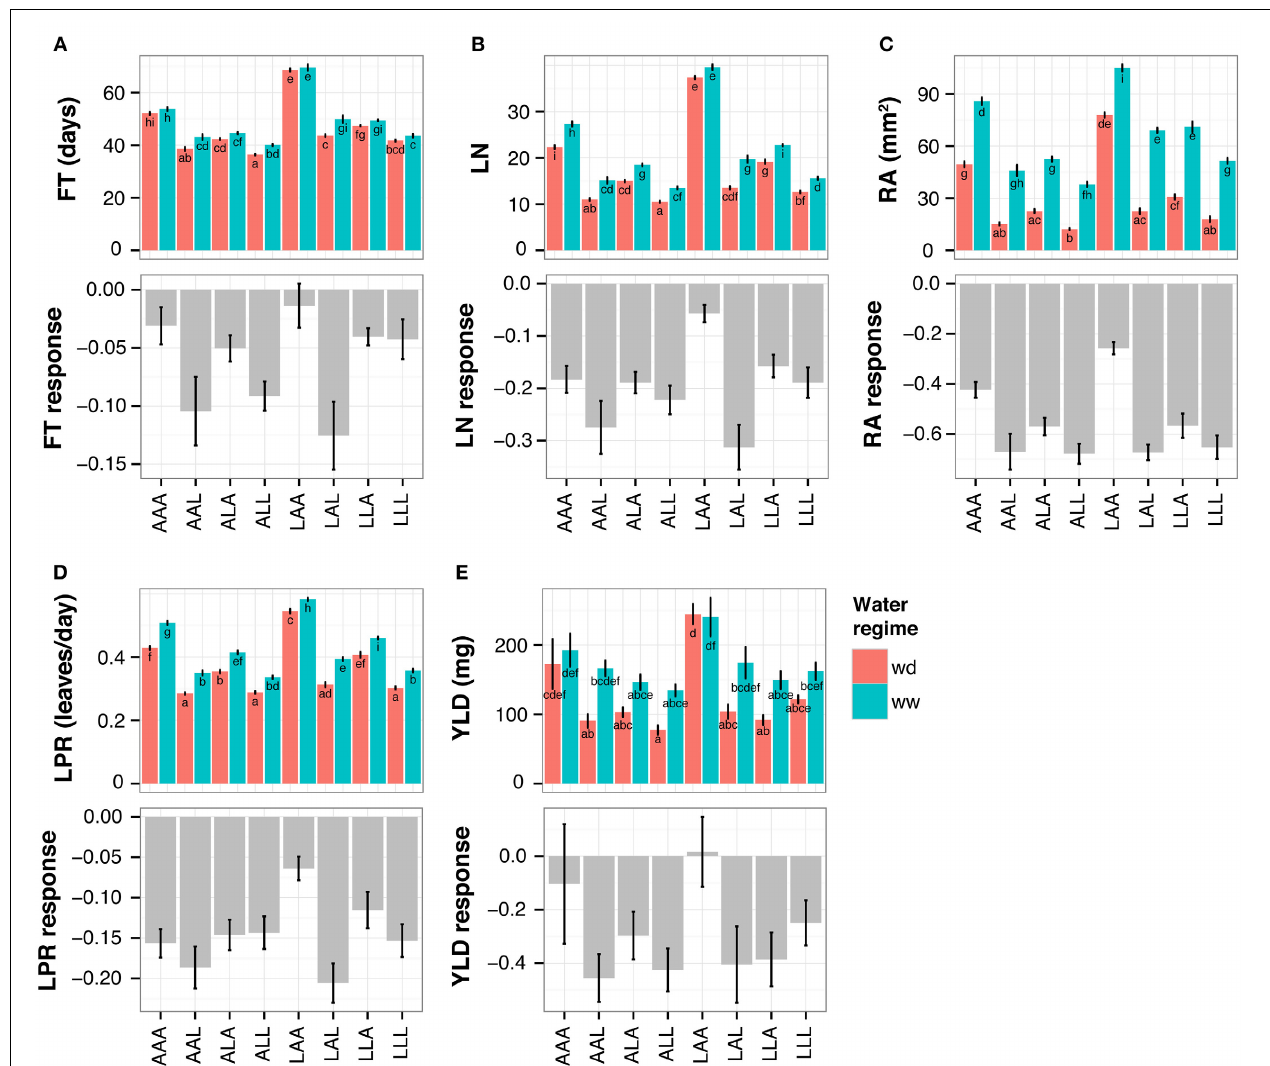
FIGURE 3 | Trait performances of NILs in both water regimes (upper panel) and in response to water deficit (lower panel, shown as relative response). At floral transition the following parameters and their responses to drought were quantified: (A) flowering time (FT; in days after sowing), (B) total leaf number (LN), (C) projected rosette area (RA) and (D) leaf production rate (LPR). Furthermore, after seed ripening (E) seed yield (YLD) and its response were quantified. The NILs are named according to their allelic combination at